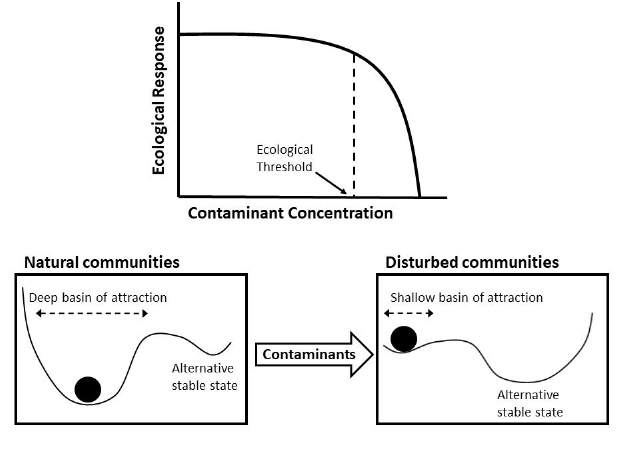
Fig. 3 . Threshold responses of communities to levels of stress (upper panel) and the effects of stressors on the transition of communities to an alternative stable state. Stressor exposure is hypothesized to reduce the depth of attraction basins, making it more likely that the community will undergo a regime shift. Greater effort is needed to restore ecosystems after regime shifts, and some systems that experienced a regime shift might not be